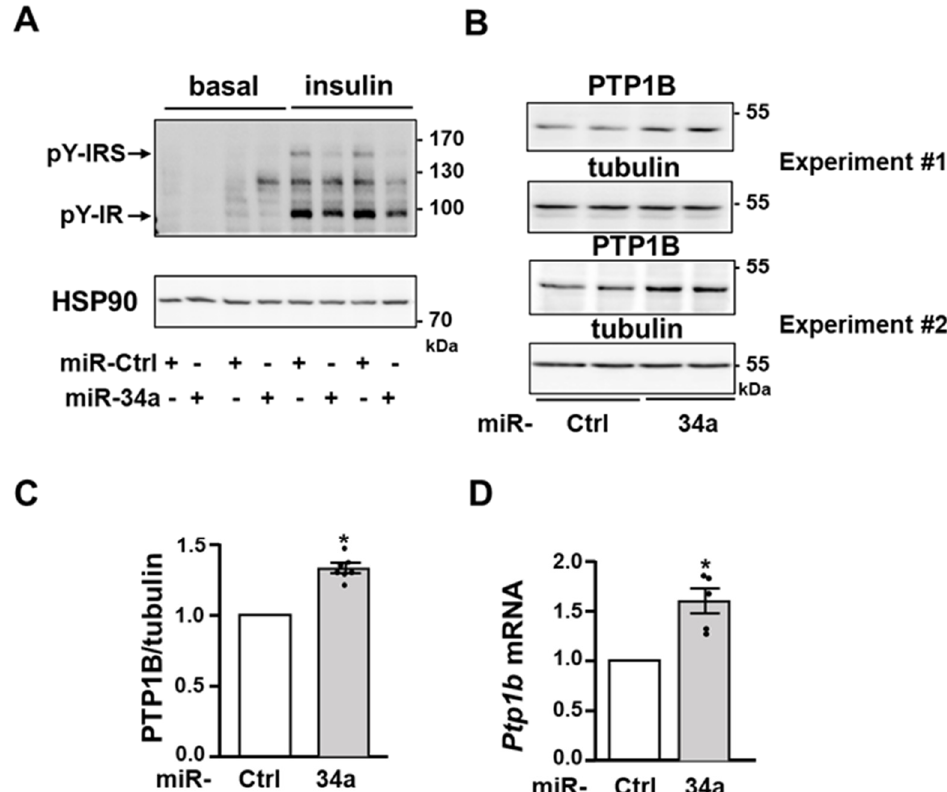
Figure 4. The expression of the tyrosine phosphatase PTP1B is increased in adipocytes overexpressing miR-34a: ( A ) Representative immunoblot of the level of tyrosine phosphorylation (pY) of IR and IRS and expression of AKT (loading control) in 3T3-L1 adipocytes transfected with a control miRNA (miR-Ctrl) or a miR-34a mimic, and treated without (basal) or with insulin (0.5 nM) for 10 min. ( B ) Immunoblot of PTP1B expression with tubulin as loading control in unstimulated 3T3-L1 adipocytes transfected as in ( A ). Immunoblots from two independent experiments are shown. ( C ) Densitometry analysis for the PTP1B/tubulin ratio ( n = five independent experiments). ( D ) Relative expression level (qPCR) of Ptp1b mRNA normalized to Rplp0 ( 36B4 ). Bar graphs are mean ± SEM. * p < 0.05.